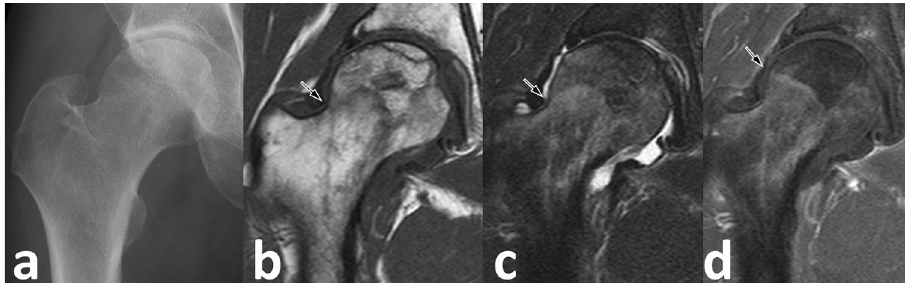
Figure 5. A 43-year-old male with a history of alcohol abuse. ( a ) An anteroposterior (AP) radiograph of the right hip. An obvious collapse is not observed at the femoral head. ( b , c ) Diffuse bone marrow edema (BME) secondary to subchondral collapse is observed on unenhanced coronal T1 ( b ) and FST2 ( c ) images (ARCO stage IIIA, BME Grade III ( b ); repetition times/echo times [TR/TE] = 554/10 ms ( c ); TR/TE = 3300/90). The arrows indicate the suspected lateral boundary of the necrotic lesion. The necrotic angle is 142° on the T1 and 139° on the FST2 images. ( d ) The contrast-enhanced MR image (TR/TE = 628/10) shows a more medial boundary ( arrow ), and the necrotic angle is 120°.